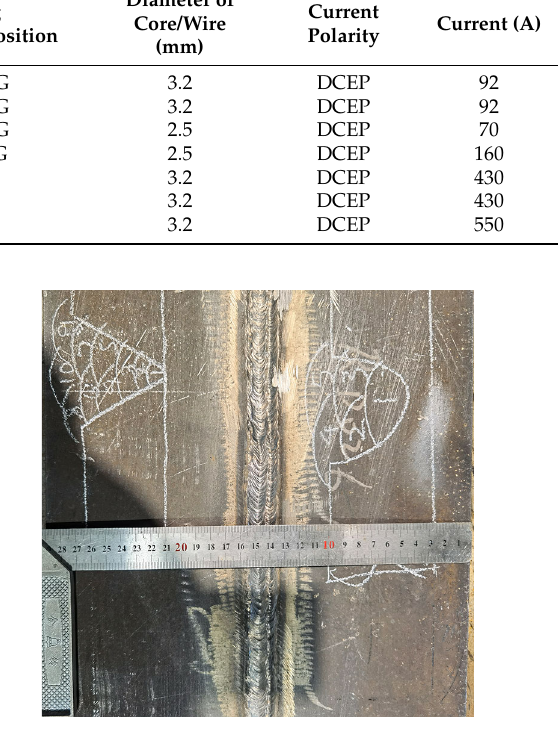
Figure 2. Appearance of the SM ‐ 1 test plate. Table 4. Welding parameters.